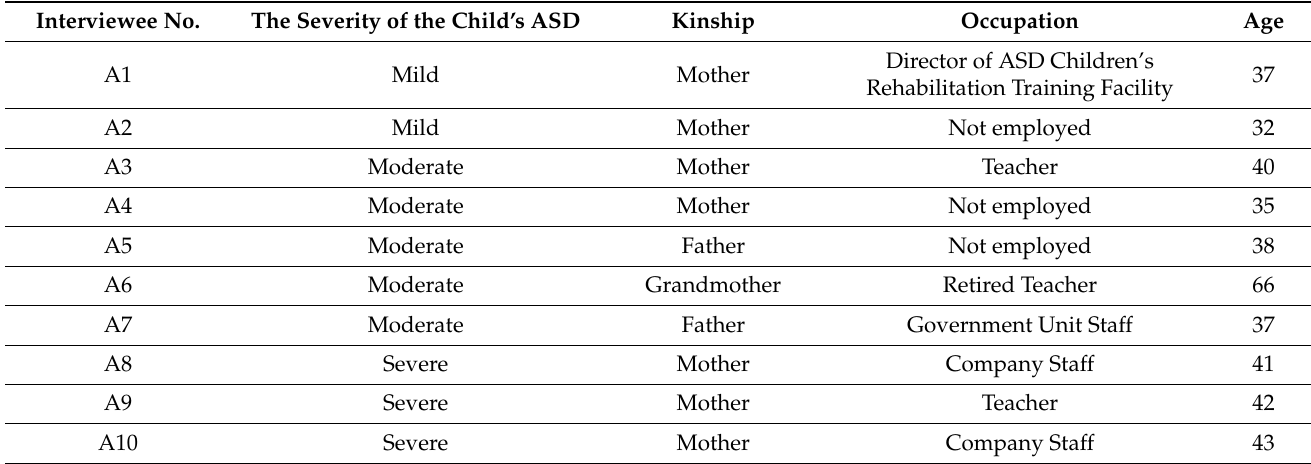
Table 2. Information about the